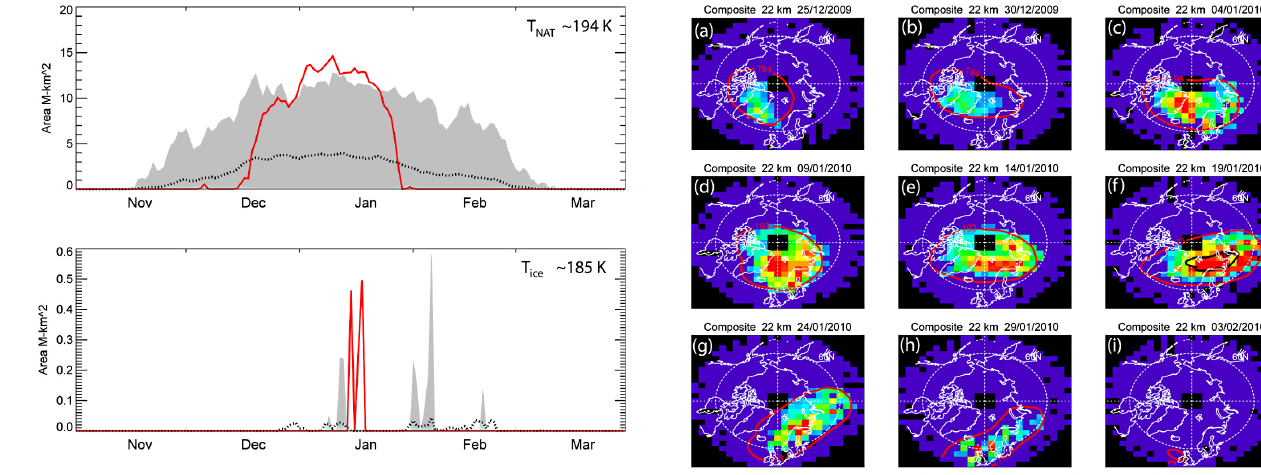
Fig. 7. A T (top panel) and A T (bottom panel) statistics at NAT ice 30hPa for the November-March period based on the temperature record for the 52-yr period 1958–2009 from the NCEP/NCAR Re- Fig. 8. Five-day composites of CALIPSO PSC frequency (number analyses 1 project. In each figure, the 52-yr daily average area is of PSC observations/total number of observations) at an altitude of depicted by the black dotted curves, the daily 95th percentile value 22km (approximately 30hPa) during the 2009–2010 Arctic winter. is represented by the upper limit of the gray-shaded region, and the Contours of T NAT (red) and T ice (black) are indicated on the daily values for the 2009–2010 winter are denoted by the red curves.